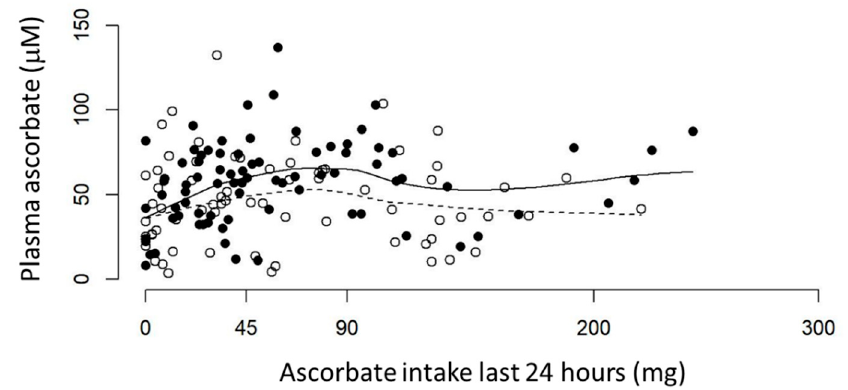
Figure 2. Ascorbate intake vs. plasma ascorbate levels in fasting patients with cancer. Pre-surgical ( • ) and therapy ( ◦ ) cohorts are shown with lines locally weighted ‘smooths’ for each group. Solid line shows pre-surgical cohort, dotted line shows therapy cohort. Plasma concentrations are from fasting patients ( < 45 mg ascorbate on day of blood draw) and ascorbate intake is from 24-hour dietary recall. Pre-surgical cohort n = 81, therapy cohort n = 69.